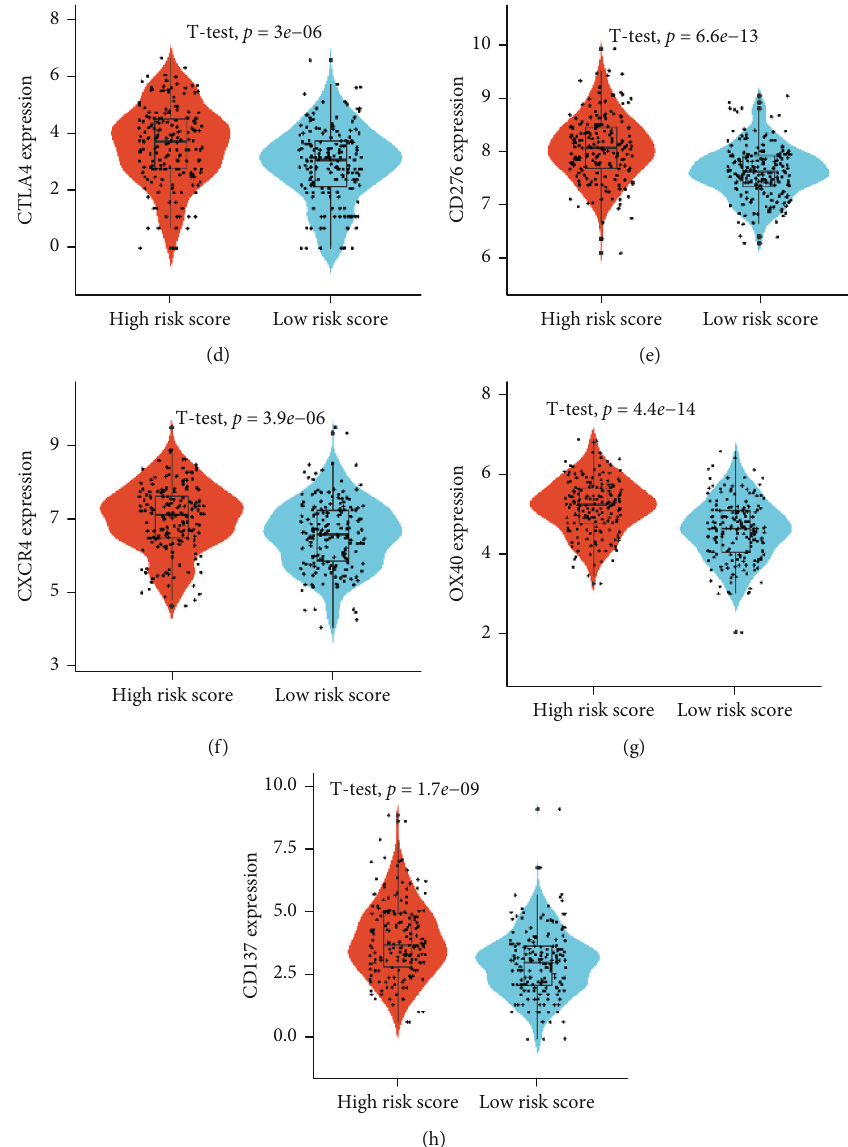
Figure 6: Immune in fi ltrates analysis. (a) Violin plot showing the abundance di ff erentiation of TIICs in two subgroups. (b – h) Di ff erential analysis of immune checkpoint genes in two